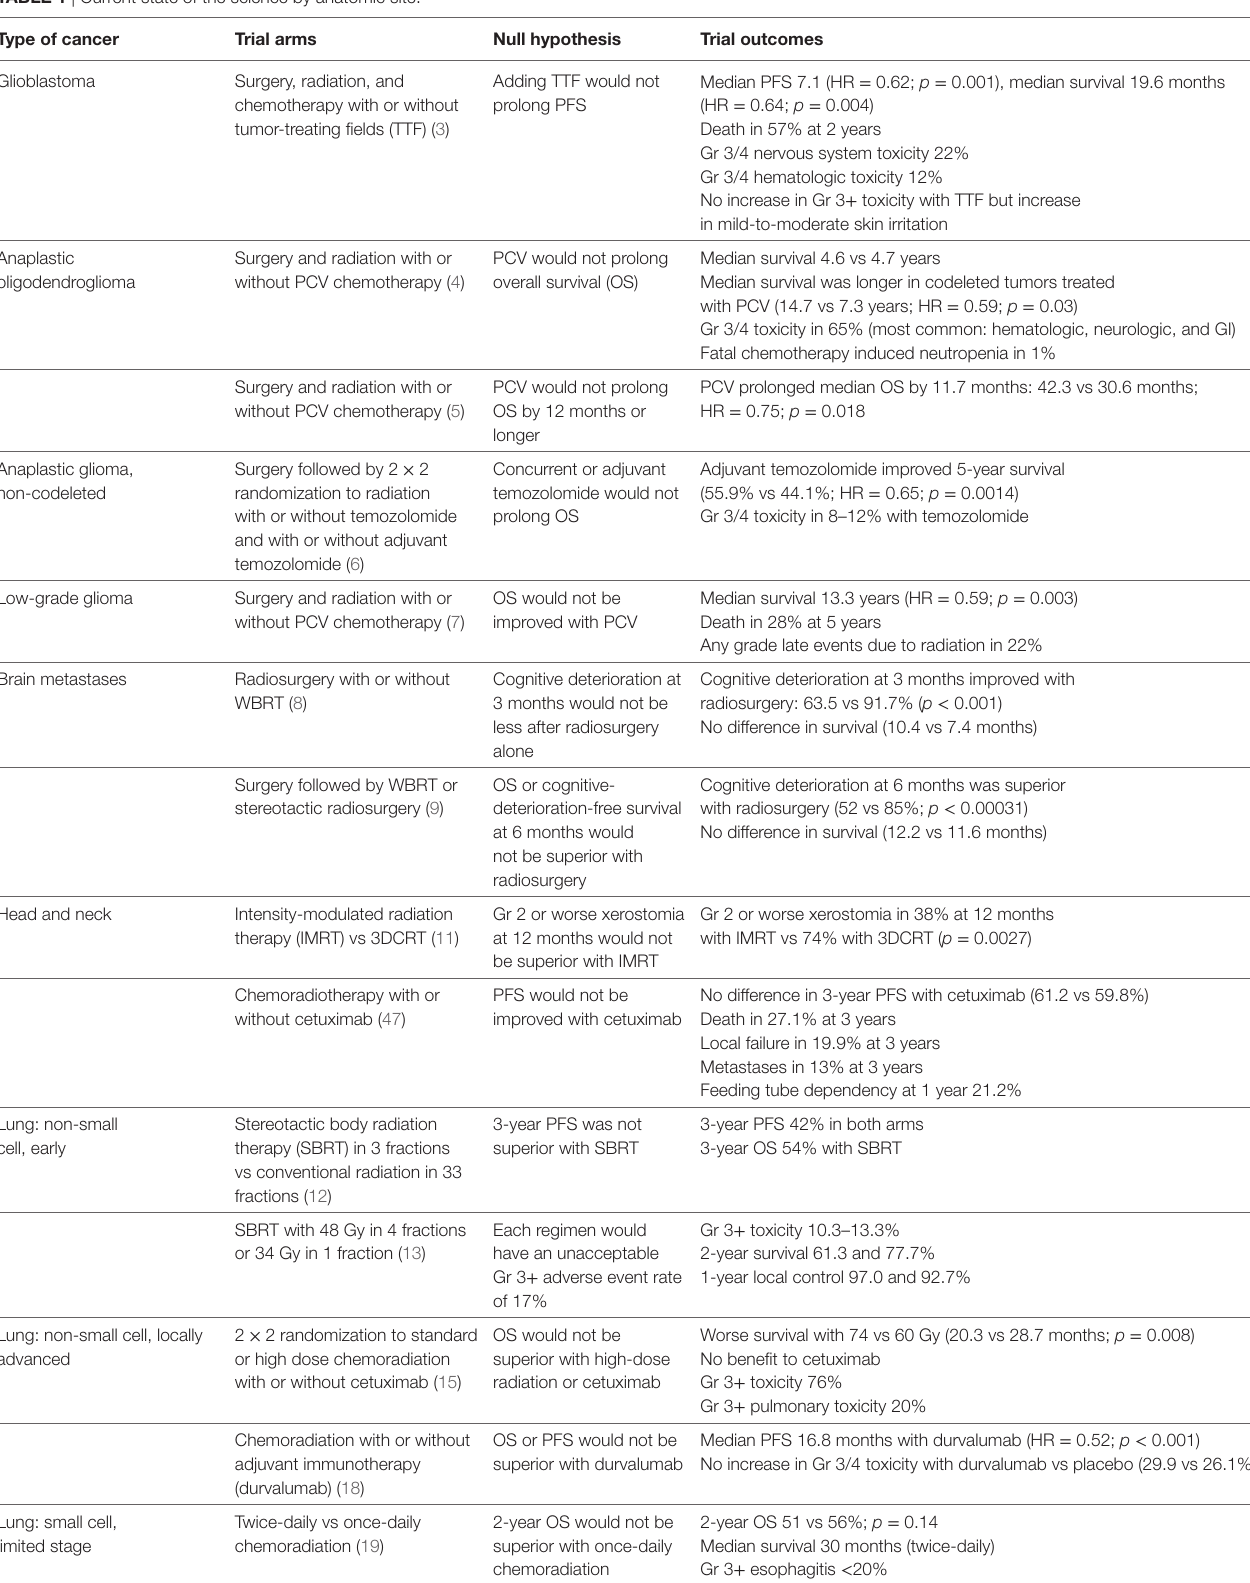
TABLe 1 | Current state of the science by anatomic